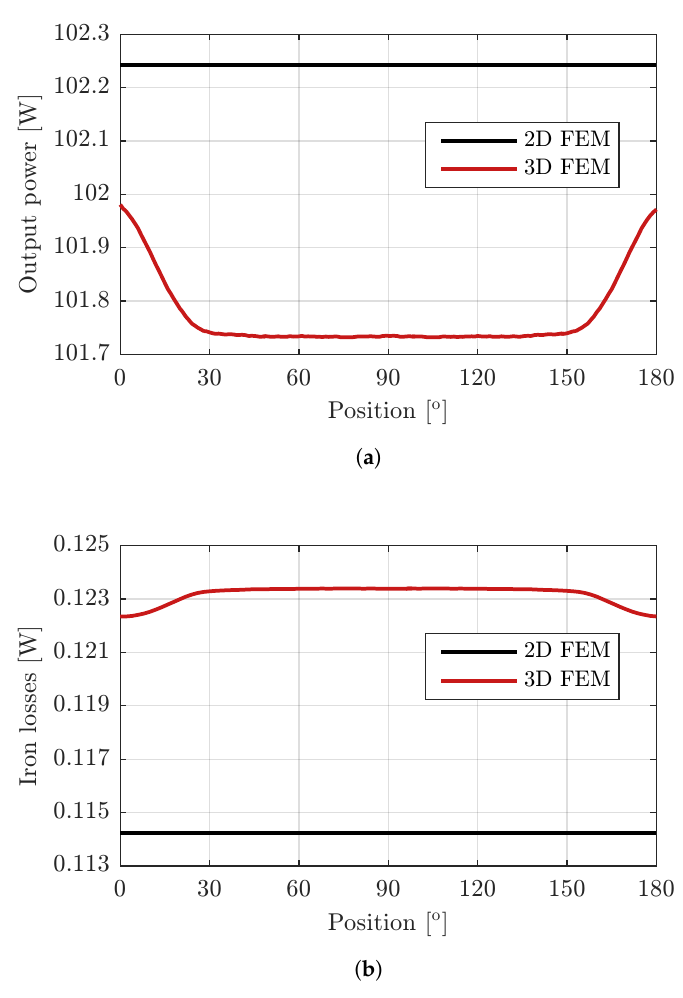
Figure 9. Comparison between the 2D and 3D model: ( a ) Output power as a function of position, and ( b ) iron losses as a function of